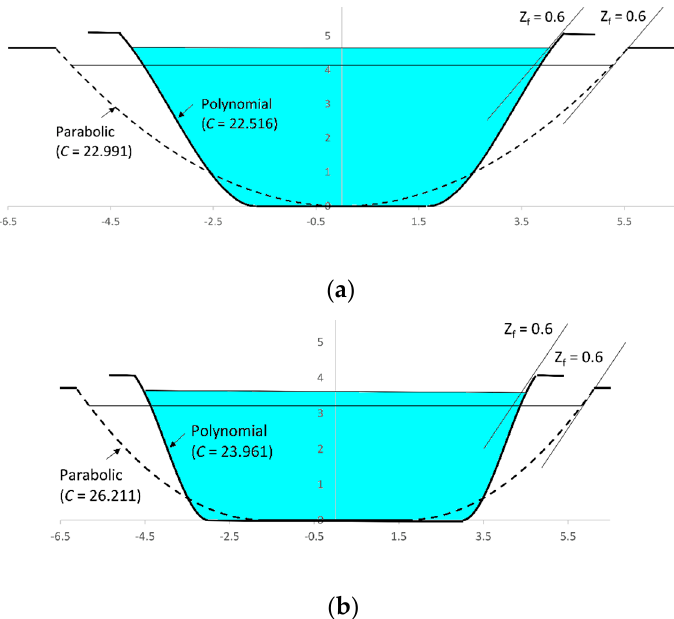
Figure 5. Comparison of simple polynomial section (POLY-SM) and parabolic section (PSHB) with restricted inverse side slope ( z f = 0.6): ( a ) Lining cost of sides is less than that of bottom ( c 1 = 0.6, c 2 = 0.1 and 0.2, c 4 = 0.4) and ( b ) lining cost of sides is greater than that of bottom ( c 1 = 0.6, c 2 = 0.4 for both sides, c 4 = 0.2).